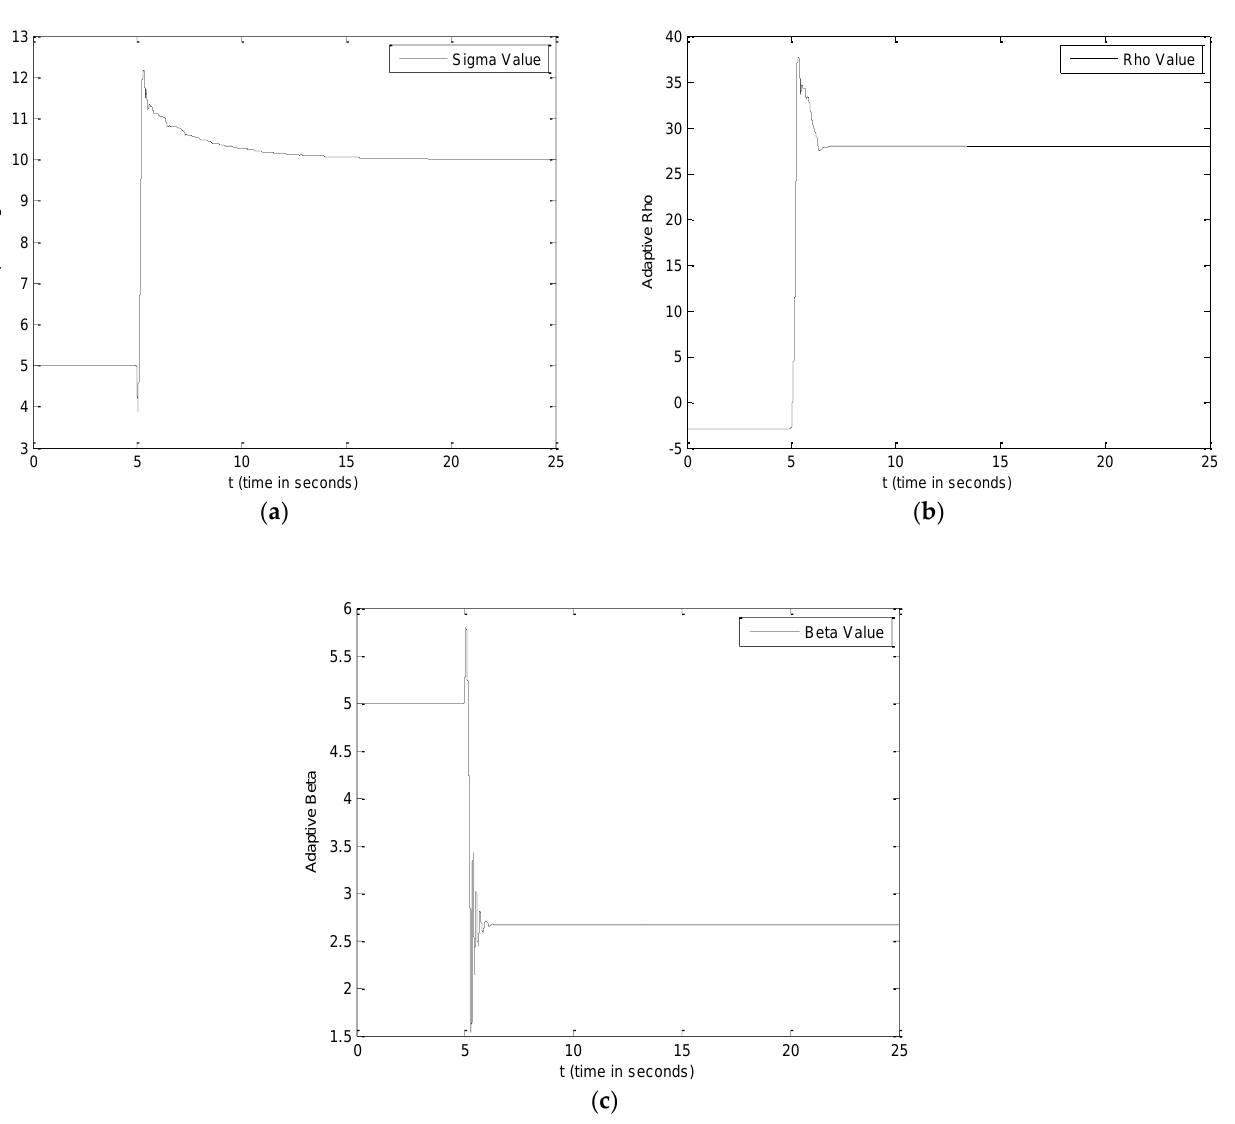
Figure 9. Graphs of synchronization (𝐚) 𝜎, (𝐛) 𝜌 and ( c ) β values of slave systems with 𝛼 𝑖 = 0.9,𝑖 = 1,2,and 3 , and time delay 𝜏 = 5 s.